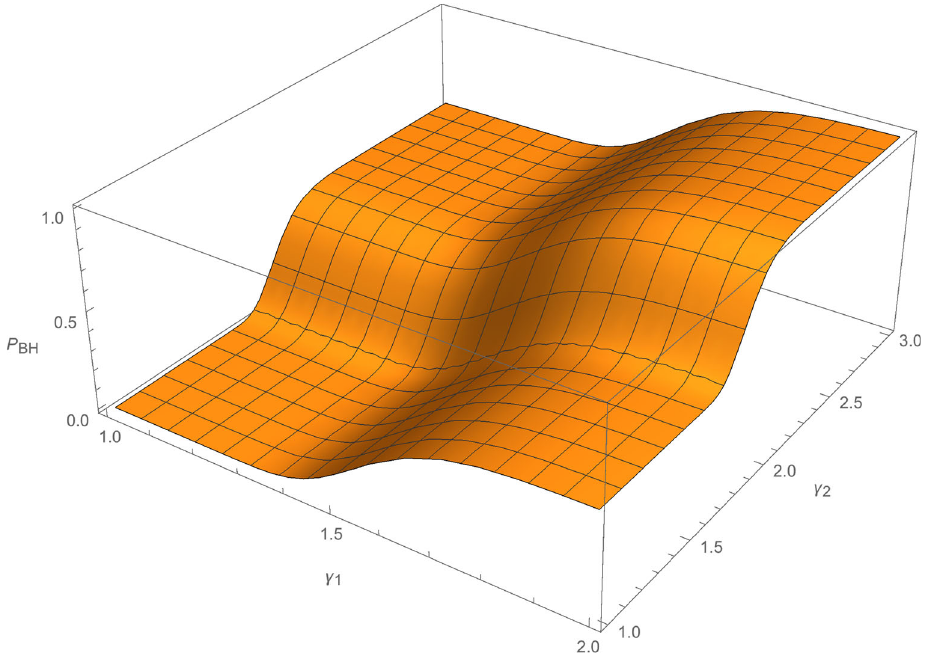
Fig. 6 Probability P BH as a function of γ 1 = R ( + )